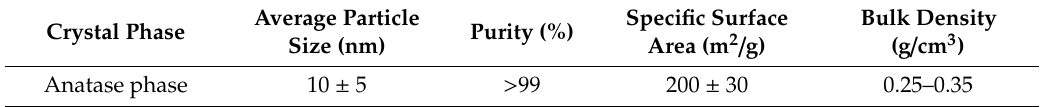
Table 2. Technical parameters of the nano-TiO 2 .